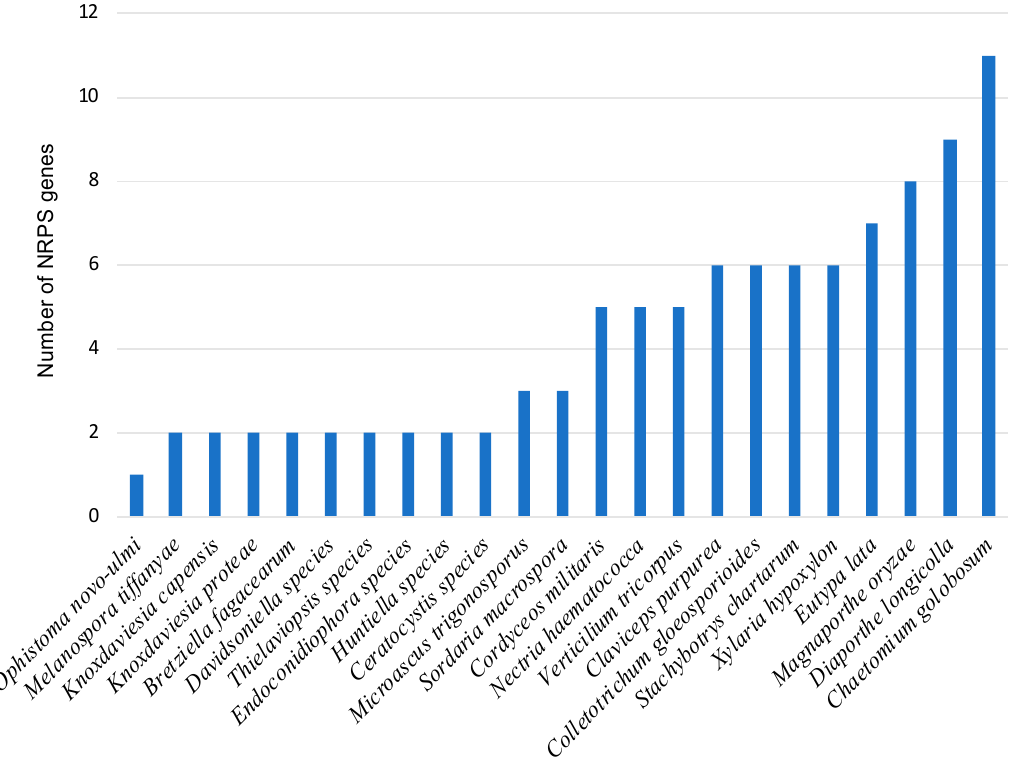
Figure 1. Number of nonribosomal peptide synthetase (NRPS) genes predicted from 40 Sordariomycetes genomes. The number of NRPS genes predicted by the online software SMURF (secondary metabolite unique regions finder) [22] and antibiotics and secondary metabolite analysis shell (antiSMASH) software [23] from 40 Sordariomycetes genomes from the National Center for Biotechnology Information (NCBI) and the Joint Genome Institute (JGI) are shown.